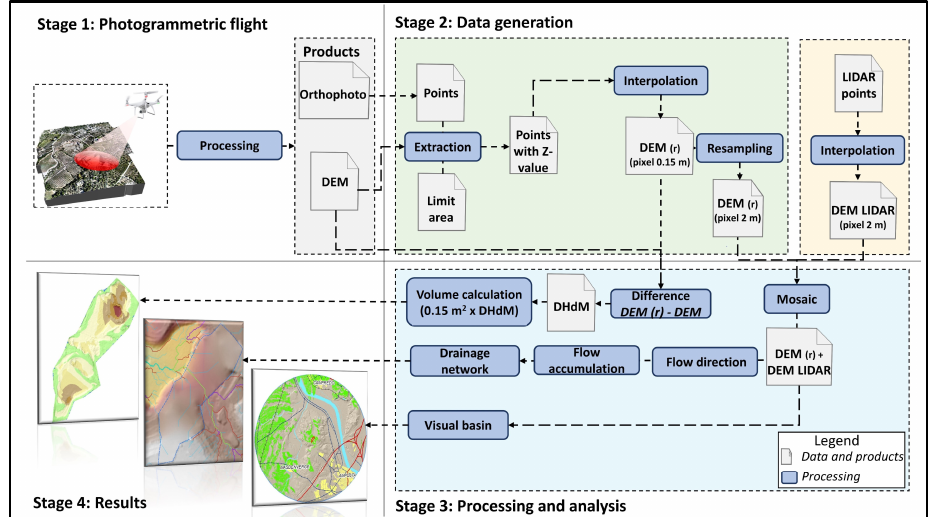
Figure 3. Methodology workflow, from Stage 1 (photogrammetric flight), Stage 2 (Data generation), Stage 3 (Processing and analysis), and Stage 4 (digital mapping results).